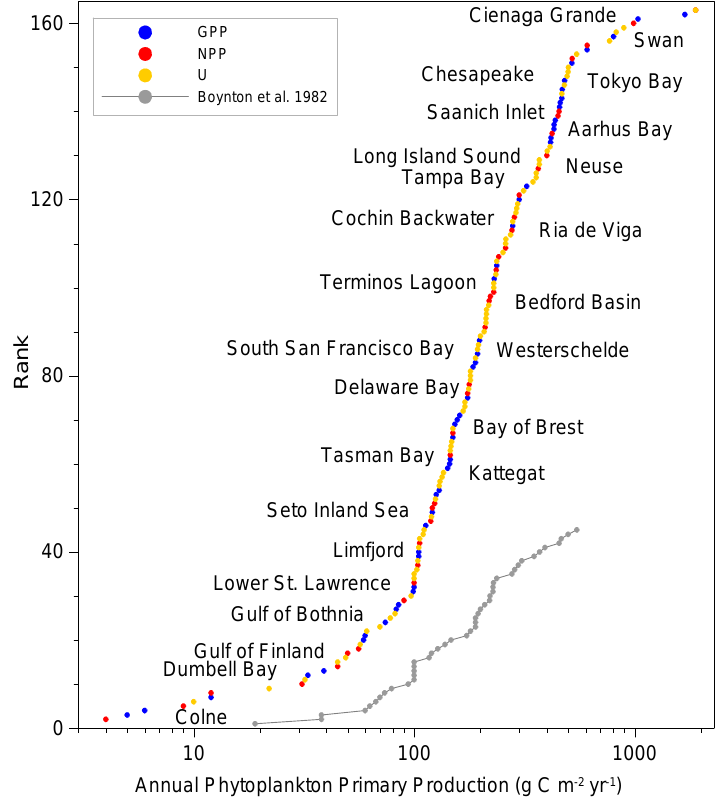
Fig. 4. Ranked distribution of median APPP reported for 131 estuarine-coastal ecosystems. U = unspecified; NPP = net primary production; GPP = gross primary production (values and data sources for each ecosystem are given in the Supplement Table S1). Thirty ecosystems are represented twice because both GPP and NPP were reported. One negative value ( − 105gCm − 2 yr − 1 ) from the Scheldt Estuary is not shown. For comparison, the gray line and circles show the ranked distribution of the 45 measurements of APPP available when Boynton et al. (1982) last reviewed phytoplankton production in